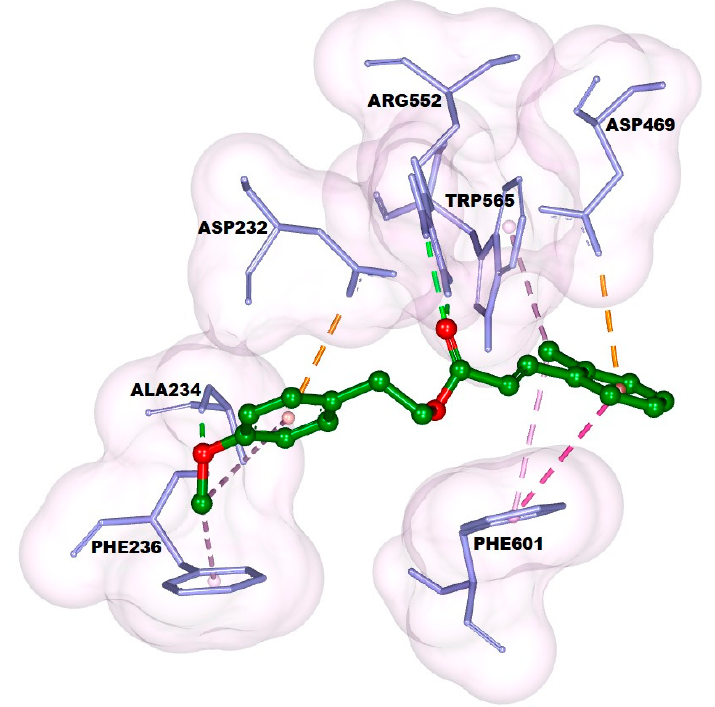
Figure 1. Docking pose of the title compound ( 1 ) against α -glucosidase.